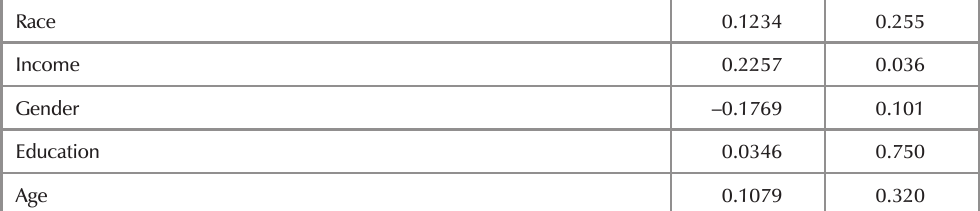
the correlation matrix in Table 5 below shows the lack of obvious dependencies between the explanatory variables